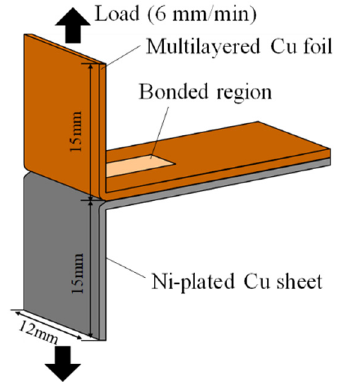
Figure 4. Tensile shear test specimen.